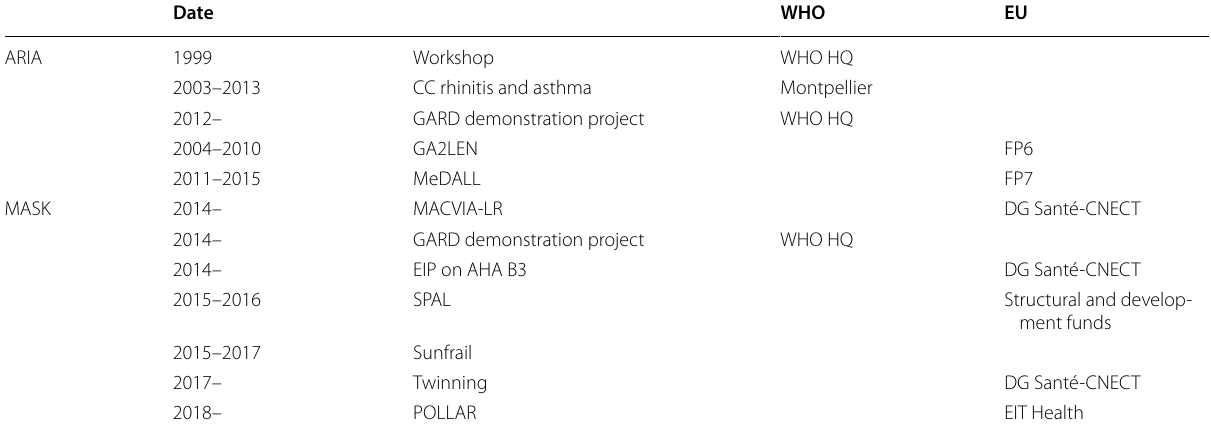
Table 1 European Union and World Health Organization links of ARIA and